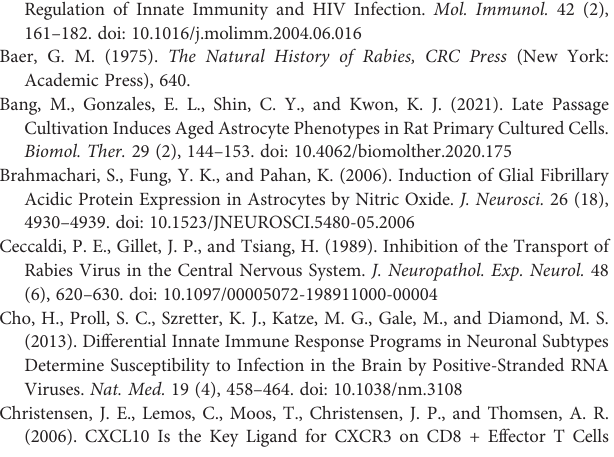
Supplementary Figure 7 | Clustering of the transcriptome pro fi le of the RABV- infected (n=10) and non-infected (control) (n=4) human post-mortem brain biopsies from group 1. (A) . Euclidian clustering of gene expression values revealed three distinct clusters. Euclidian clustering was performed by clustering the gene expression values ( D CT) using R version 3.4.4. (B) PCA of gene expression values revealed a separation into three distinct clusters. PCA clustering was performed by clustering the gene expression values ( D CT) by using R version 3.4.4. (C) The determination of the number of clusters was validated by calculating the relative cluster variation. Cluster variation was calculated by dividing the in-cluster variation by the total variation using R version 3.4.4. Supplementary Figure 8 | Validation of astrocytic phenotype. (A) Representative images showing GFAP staining of mAstrocytes (B) Quanti fi cation of relative Gfap expression of murine N2A cells and mAstrocytes isolated from murine pups. All experiments were performed three times independently. Bars show the mean D CT values ± SD. Differential expression was calculated by applying an unpaired t-test (**** p-value < 0.0001). GFAP, Glial fi brillary acidic protein; mAstrocytes, murine cortical astrocytes; NI, non-infected; N-protein, nucleoprotein. Supplementary Figure 9 | Pathways activated in the post-mortem brain of rabid patients. Colours present the fi ve most presented molecular functions from gene ontology (strength > 2.27, FDR < 0.0011): red = interleukin 10 receptor activity (GO:0004920), blue = CCR5 chemokine receptor binding (GO:0031730); green = interferon receptor activity (GO:0004904), yellow = CCR1 chemokine receptor binding (GO:0031726), purple = TAP binding (GO:0046977). Networks were generated by performing a functional enrichment analysis based on gene expression ranks and SD using the STRING version